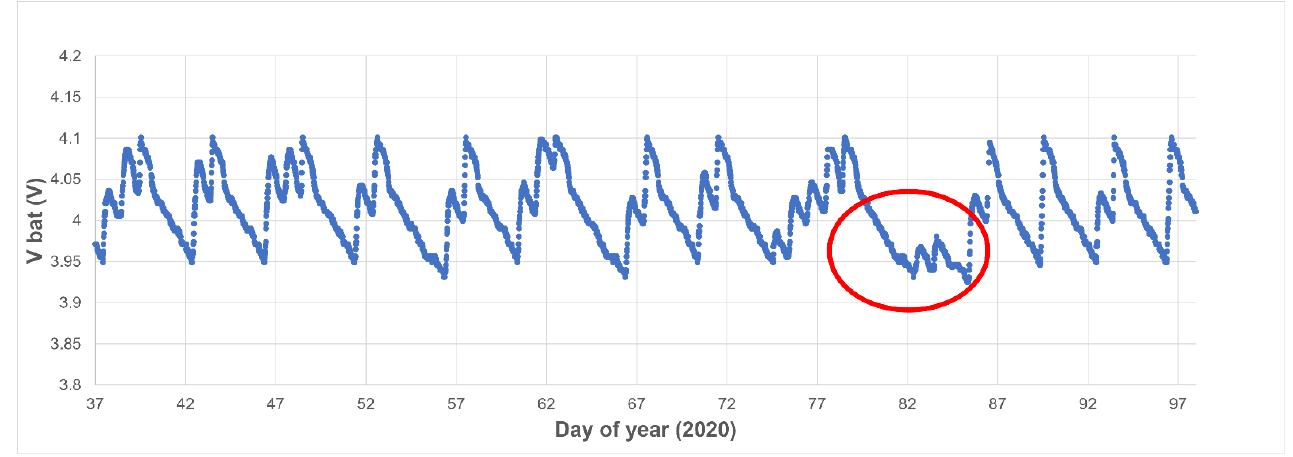
Figure 14. Typical behavior of the battery voltage in a node without operational problems.